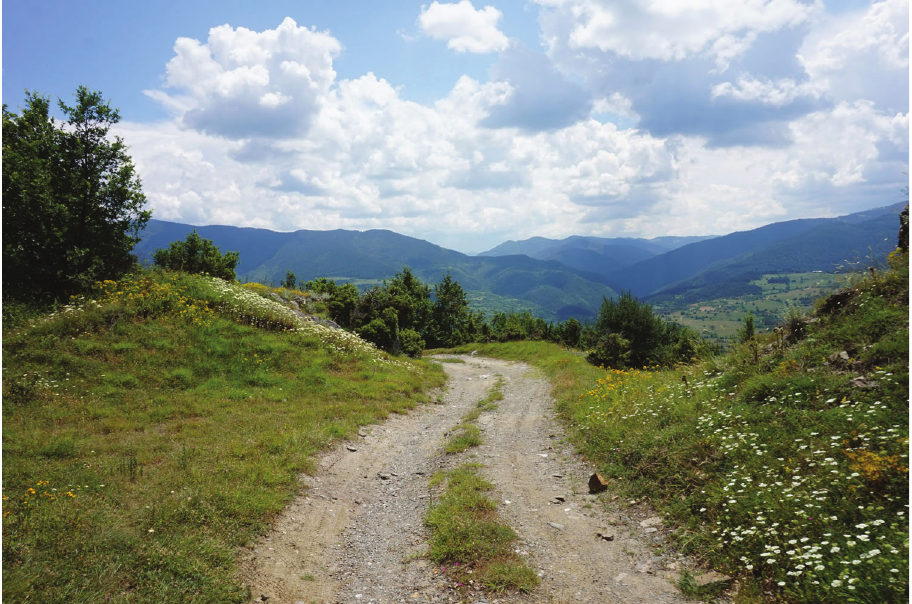
Figure 37. Habitat of P. orphicus orphicus in its type locality. Bulgaria, Hvoyna, 3 July 2016. Photo by E.